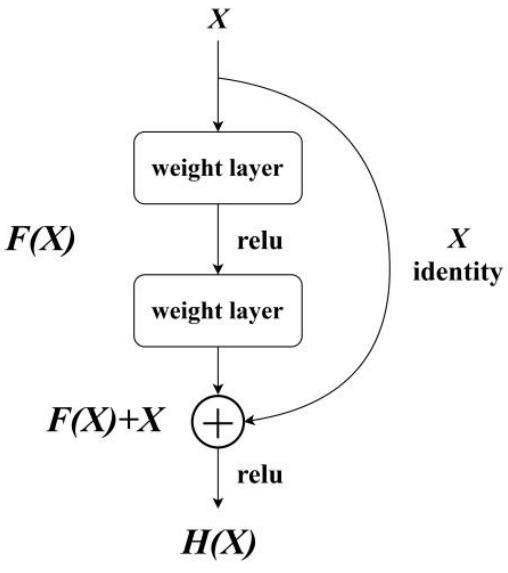
Figure 2. Shortcut connections.